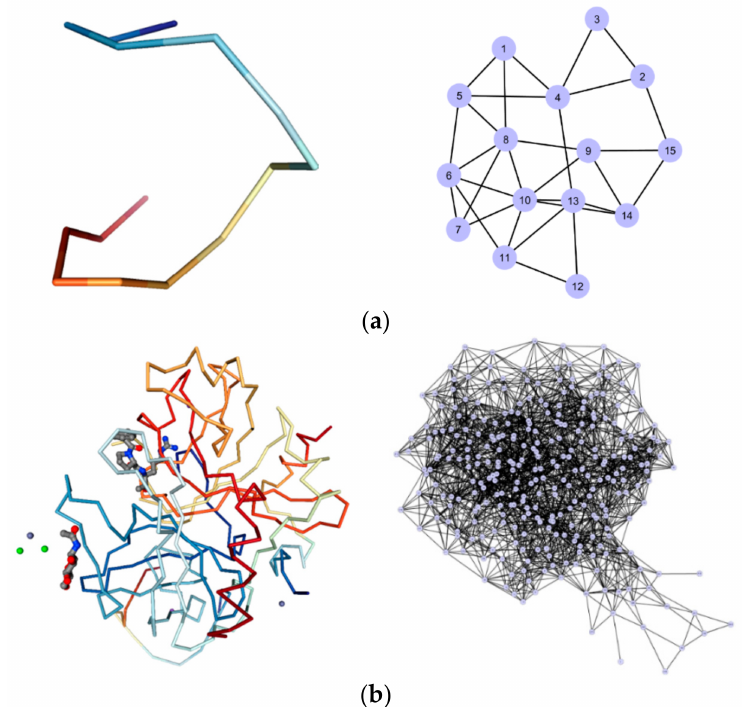
Figure 3. ( a ) The 3D structure of the TBA in the native state (Entry 148D_1 [46]) on the left, and the corresponding graph at RC = 10 Å on the right; ( b ) the 3D structure of the TBA-thrombin complex (Entry 4DII [46]) on the left, and the corresponding graph at R C = 10 Å on the